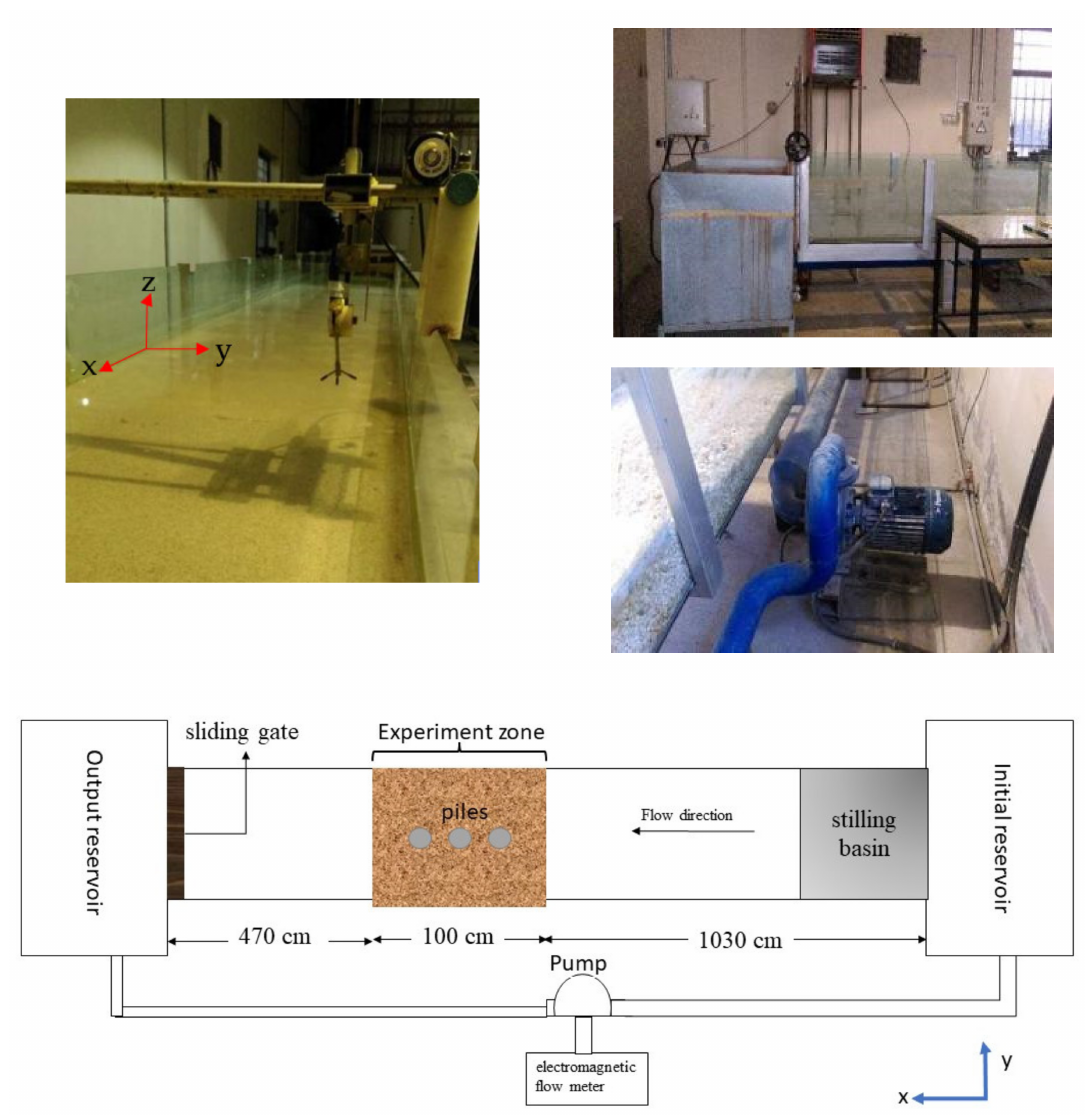
Figure 2. Experimental setup and a scheme of the flume at